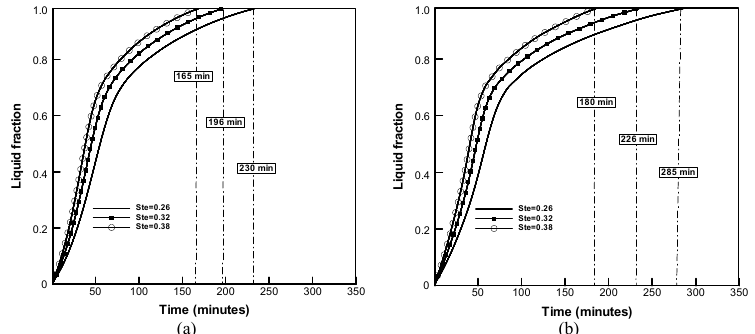
Figure 8. Numerical results showing liquid fraction variation versus time at different Stefan numbers: (a) 26mm annular fin heat exchanger and (b) 13mm annular fin heat exchanger.